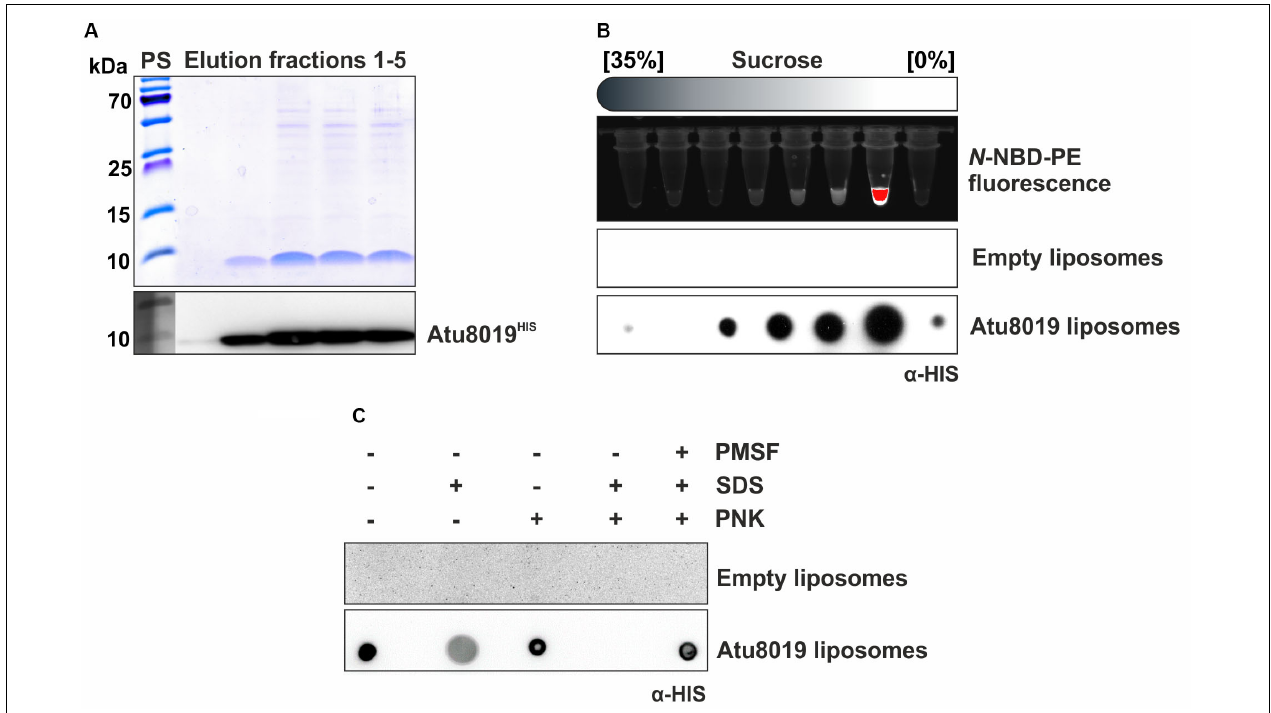
FIGURE 6 | Purification and reconstitution of Atu8019 HIS into liposomes. (A) SDS gel and Western blot analysis of elution fractions after Ni-IDA purification of Atu8019 HIS . (B) Efficiency of Atu8019 HIS reconstitution in liposomes containing the reporter lipid NBD-PE was analyzed by a flotation assay of Atu8019 HIS proteoliposomes in a sucrose gradient. Fractions were analyzed for NBD fluorescence (lipid marker) and protein content (Dot blot using anti-HIS antibodies). Reconstitution was evident from co-migration of phospholipid and Atu8019 HIS . (C) Proteinase K (PNK)-protection assay with reconstituted liposomes. A Dot blot using anti-HIS antibodies was conducted to detect Atu8019 HIS in intact or SDS-treated